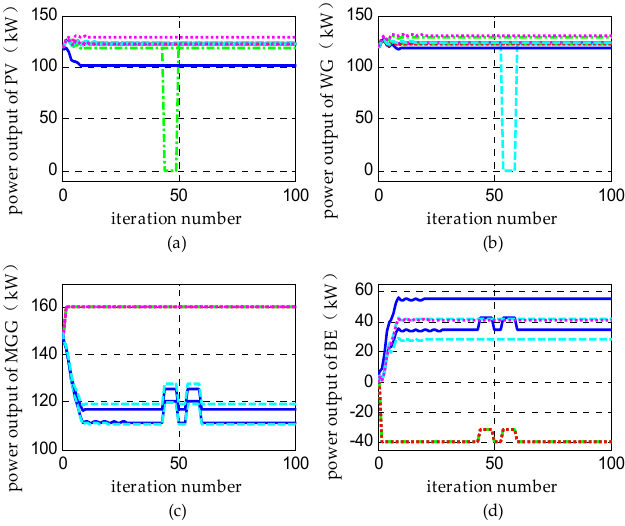
Figure 14. Dispatch results in Scenario F . ( a ) Power output of PV; ( b ) Power output of WG; ( c ) Power output of MGG; and ( d ) Power output of BE.